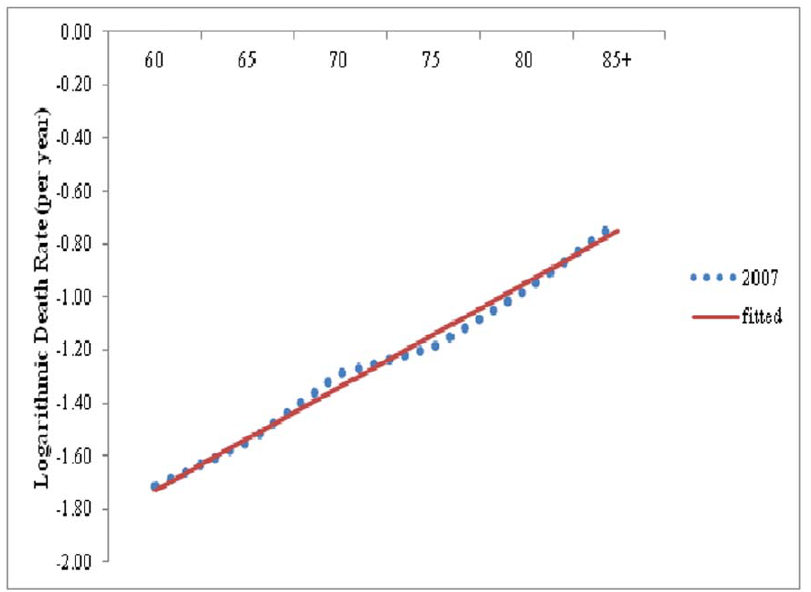
Figure 1. Age Specific death rates for female on logarithmic scale, India, 2007 ( Note : Dotted are logarithmic of death rates between 60 and 85 + . The line was fitted to death rates between age 60 and 85 by ordinary least squire regression).